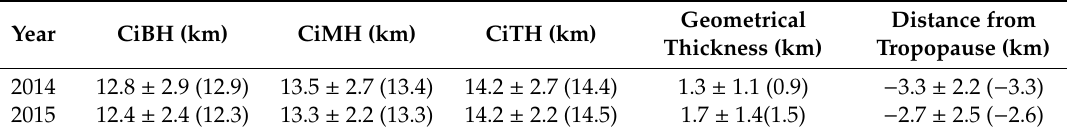
Table 2. Mean, standard deviation, and median (parentheses) of geometrical properties of cirrus clouds observed over Gadanki, India (13.5 ◦ North; 79.2 ◦ North).